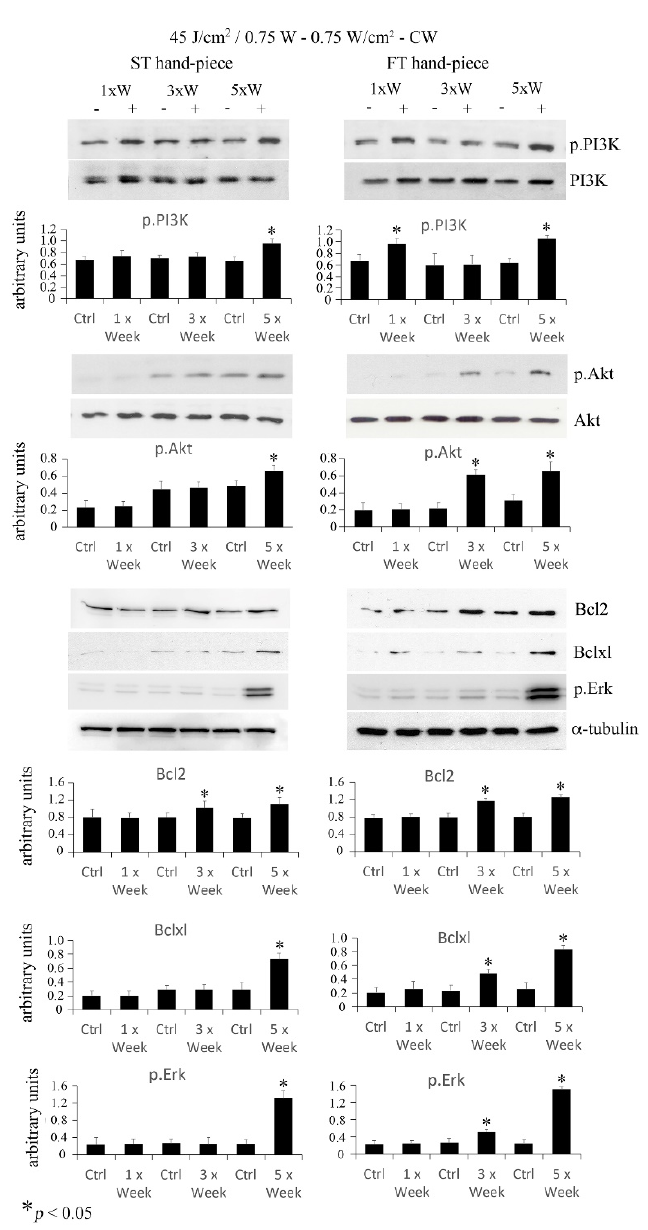
Figure 3. Effect of 45 J/cm 2 –0.75 W laser treatment on anti-apoptotic/pro-survival markers. The frequency of irradiation was once per week (1× Week), three times (alternate day, 3× Week), and five times (every day, 5× Week). Western blotting analysis of p.PI3K, p.Akt, Bcl2, Bclxl, and p.Erk was performed ( n = 3). Note the increase in pro-survival proteins, which was particularly evident using the FT device (values represent means ± S.E., * p < 0.05 compared to the control).